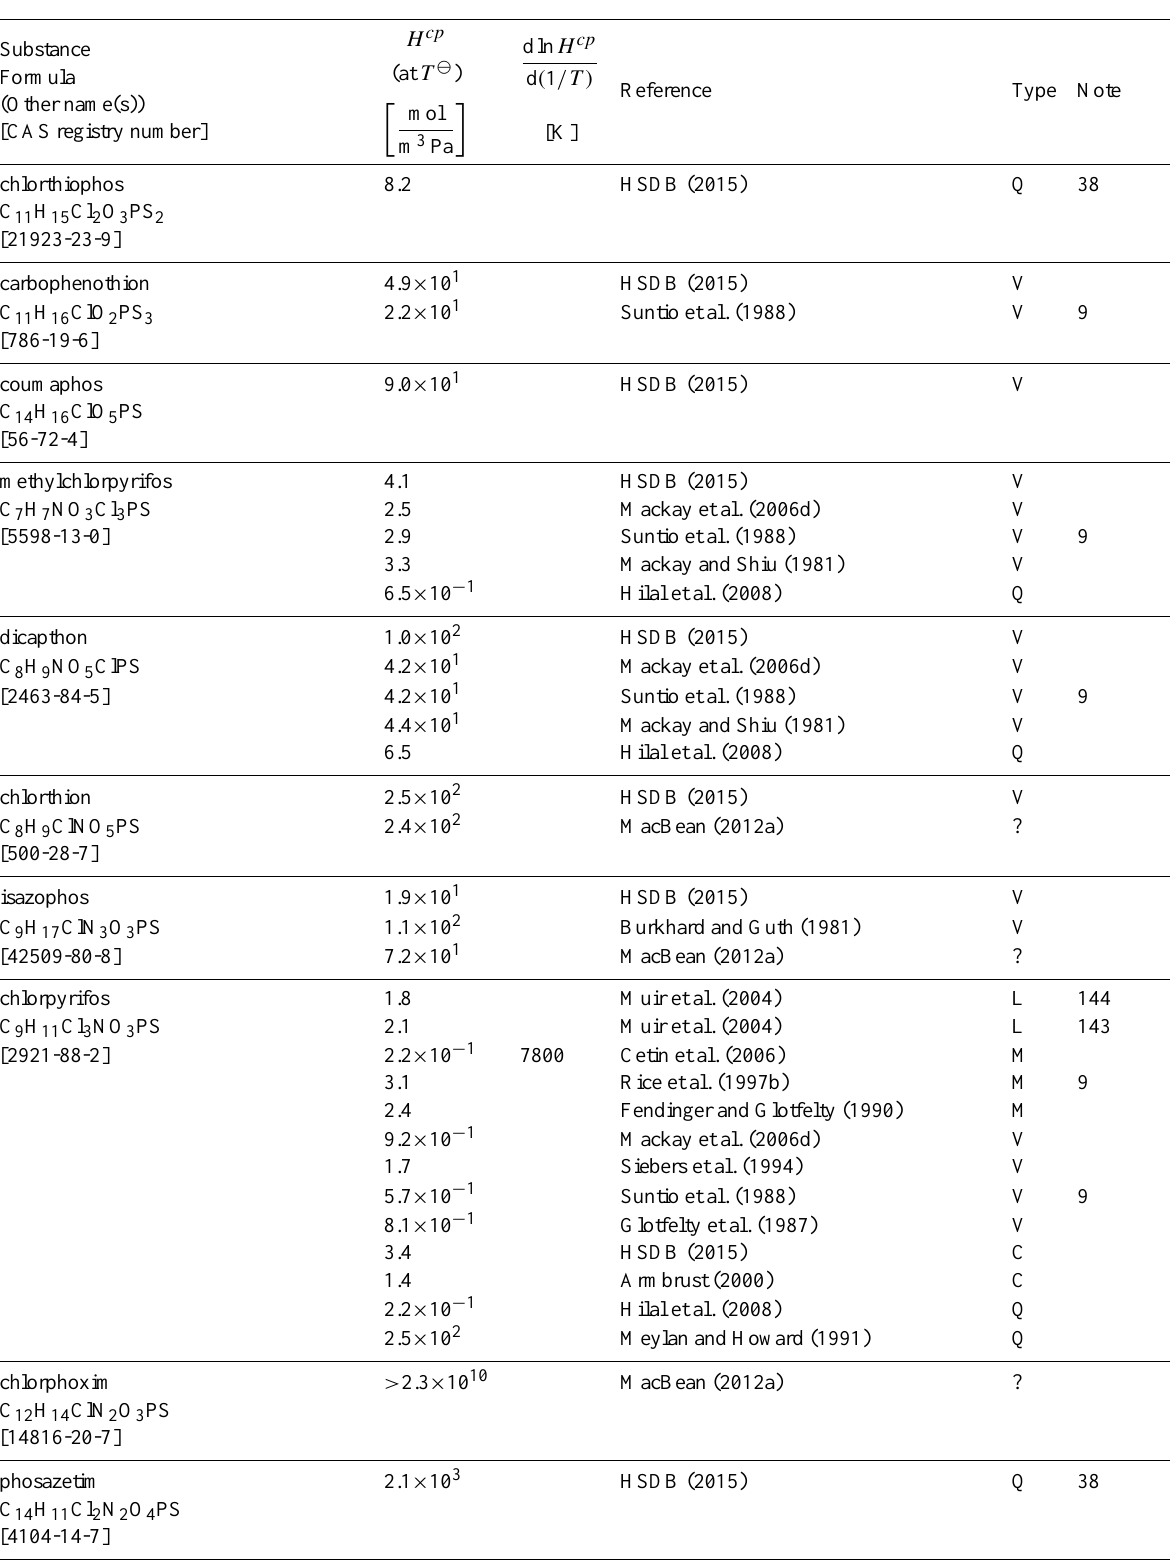
Table 6: Henry’s law constants for water as solvent